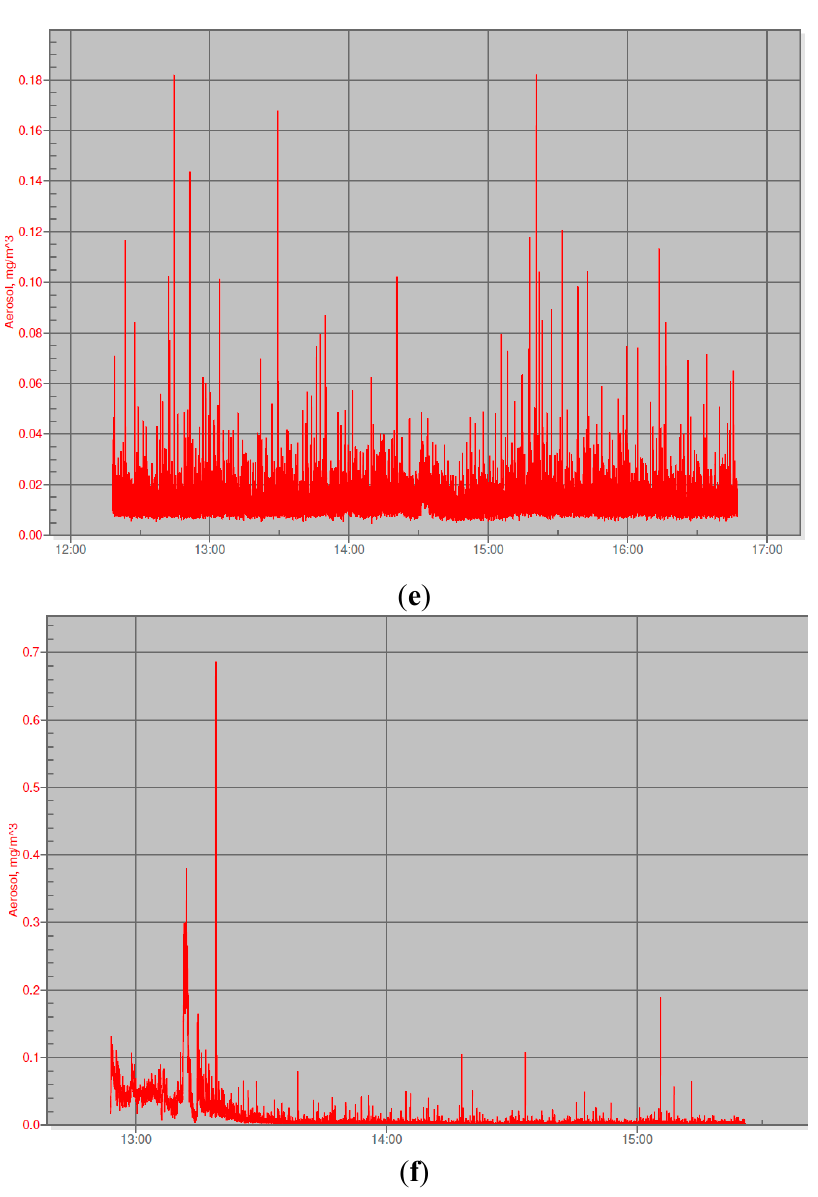
Figure 1. ( a ) Continuous monitoring of PM with a Sidepak from 18:00 to 03:00 the following day—no smoking reported; ( b ) Continuous monitoring of PM with a Sidepak—no smoking reported, bread baking occurred; ( c ) Continuous monitoring of PM with a Sidepak—smoking in the home; ( d ) Continuous monitoring of PM with a Sidepak—smoking in the home; ( e ) Continuous monitoring of PM with a Sidepak—outdoor air pollution; ( f ) Continuous monitoring of PM with a Sidepak—no smoking, outdoor air pollution.